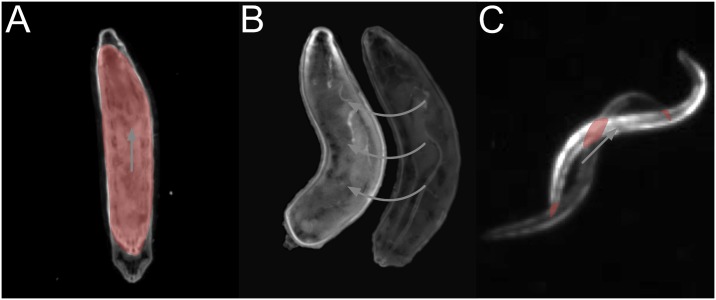
Examples of different assignment strategies.Overlapping regions are given in red and locomotion is indicated by arrows. (A) During forward locomotion of Drosophila larvae the association can be done using overlap-based costs and the Hungarian algorithm. (B) Given rolling behavior of Drosophila larvae, an assignment using contour overlaps as costs for the Hungarian algorithm might fail due to inappropriate frame rates. (C) For tracking the snake-like motion of C. elegans, contour-based assignments might be insufficient.